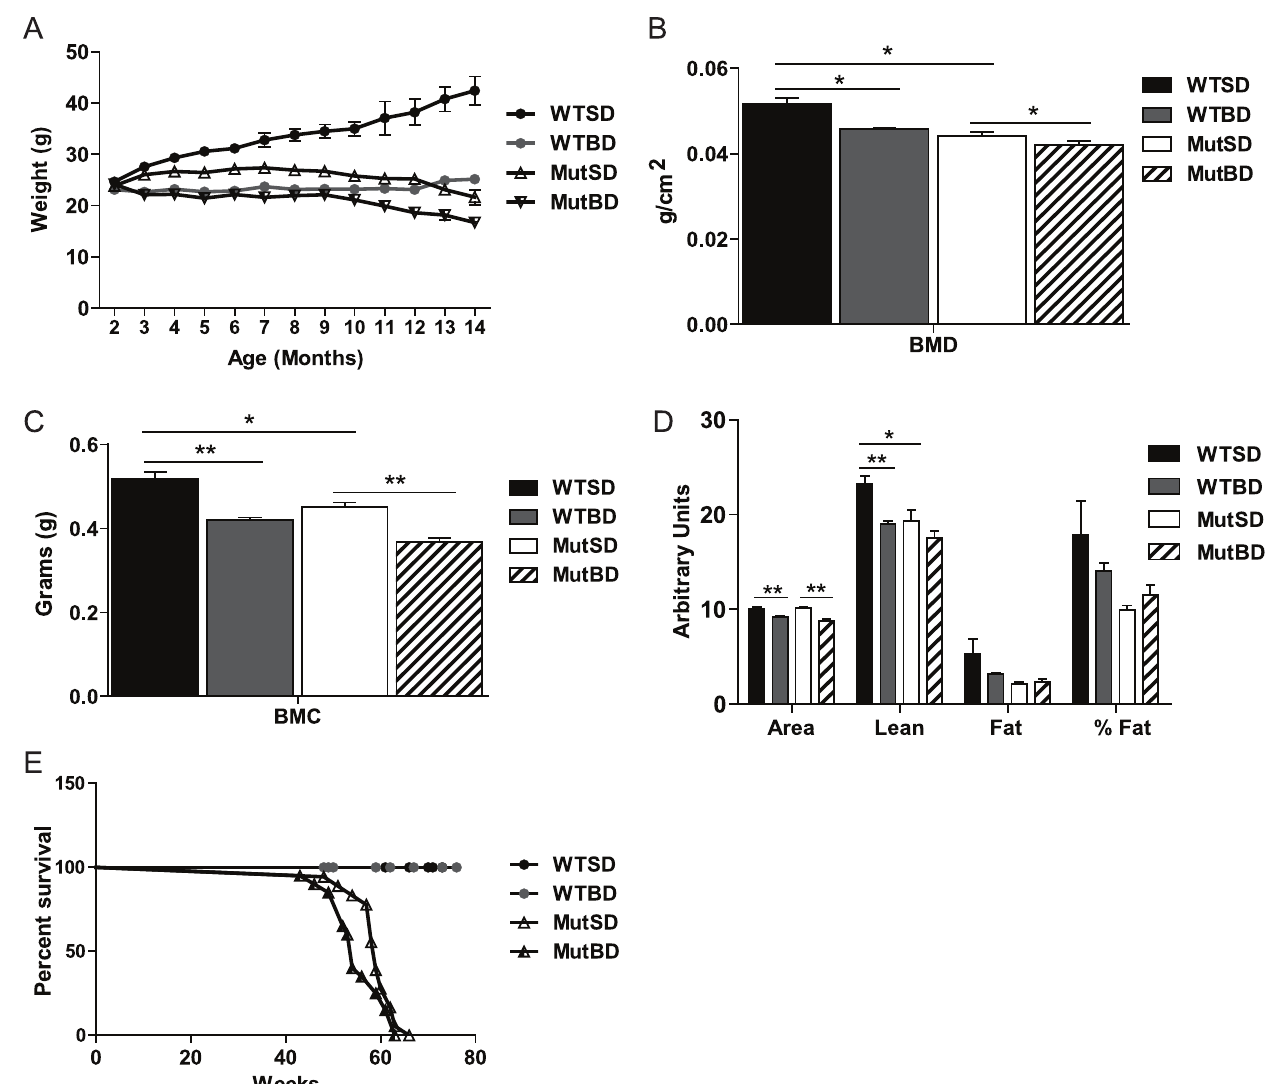
Figure 1. Systemic effects of bezafibrate on Mut and WT mice. (A) Body weight of mice from 2 to 14 month-old (n=11–26/group for 2 to 11 months; 2–6/group for 12 to 14 months). The difference in body weight between WTSD and MutSD mice is statistically significant from 3 to 14 months, between WTSD and WTBD mice is significant at every time point and the difference between MutSD and MutBD is significant from 3 to 14 months. Measurement of total (B) bone mineral density (BMD), (C) bone mineral content (BMC) (D), body area (cm 2 ), lean mass (g), total body fat (g) and percent (%) fat of 10 month-old mice (n=5–7/group). (E) Percent survival of mice (n=11–15/group). *, P , 0.05; **, P , 0.01, Student’s t -test. Error bars represent the